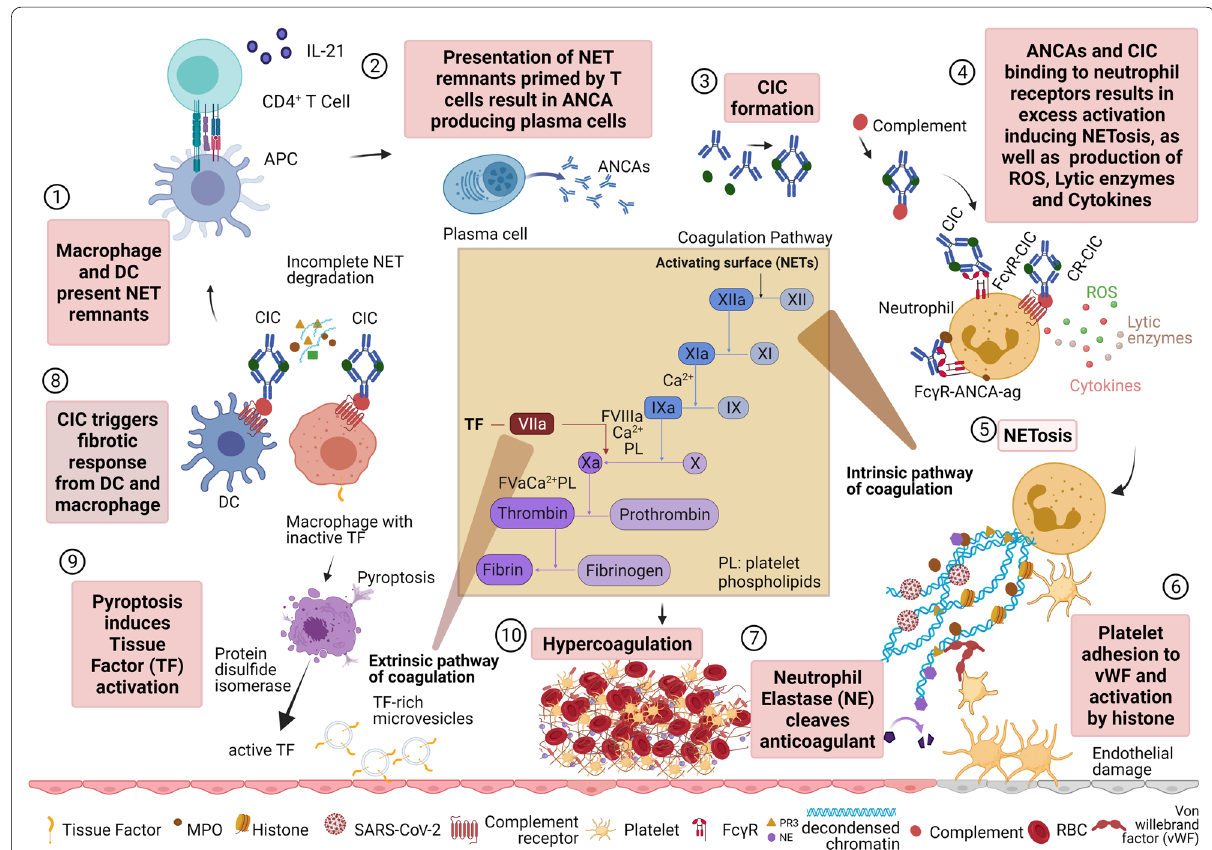
Fig. 2 Incomplete NET degradation leads to hypercoagulation. (1) Incomplete NET degradation causes macrophage and dendritic cells (DCs) to present NET components to CD4 T cells. (2) The T cells release IL-21 inducing differentiation of B cells into plasma cells to induce autoantibody + production. (3) Anti-neutrophil cytoplasmic antibodies (ANCAs) can form circulating immune complex (CIC). (4) ANCAs and CIC activate neutrophils through Fc ɣ R and complement receptor binding. Hyperactivation of neutrophils by autoantibodies produces Reactive Oxygen Species (ROS), cytokines storms, lytic enzymes, and NET. (5) NETosis releases decondensation of chromatin constructed from unwound neutrophil DNA and histones coated with neutrophil enzymes such as neutrophil elastase (NE), myeloperoxidase (MPO), and proteinase 3 (PR3). (6) Von Willebrand Factor (vWF) attracts platelets and histones activate them leading to the intrinsic pathway of coagulation. (7) NE cleaves anticoagulant which contributes to more coagulation. (8) CIC can trigger a fibrotic response from DCs and macrophages. (9) Macrophages carry inactive tissue factors which will be activated by pyroptosis, specifically by protein disulfide isomerase. Pyroptosis results in microvesicles that contain active tissue factors that lead to the extrinsic pathway of coagulation. (10) The vicious cycle of uncontrolled neutrophils activation and incomplete net degradation causes hypercoagulation through intrinsic and extrinsic pathways. Created with BioRender.com and adapted from Bautista-Becerril et al. (2021)